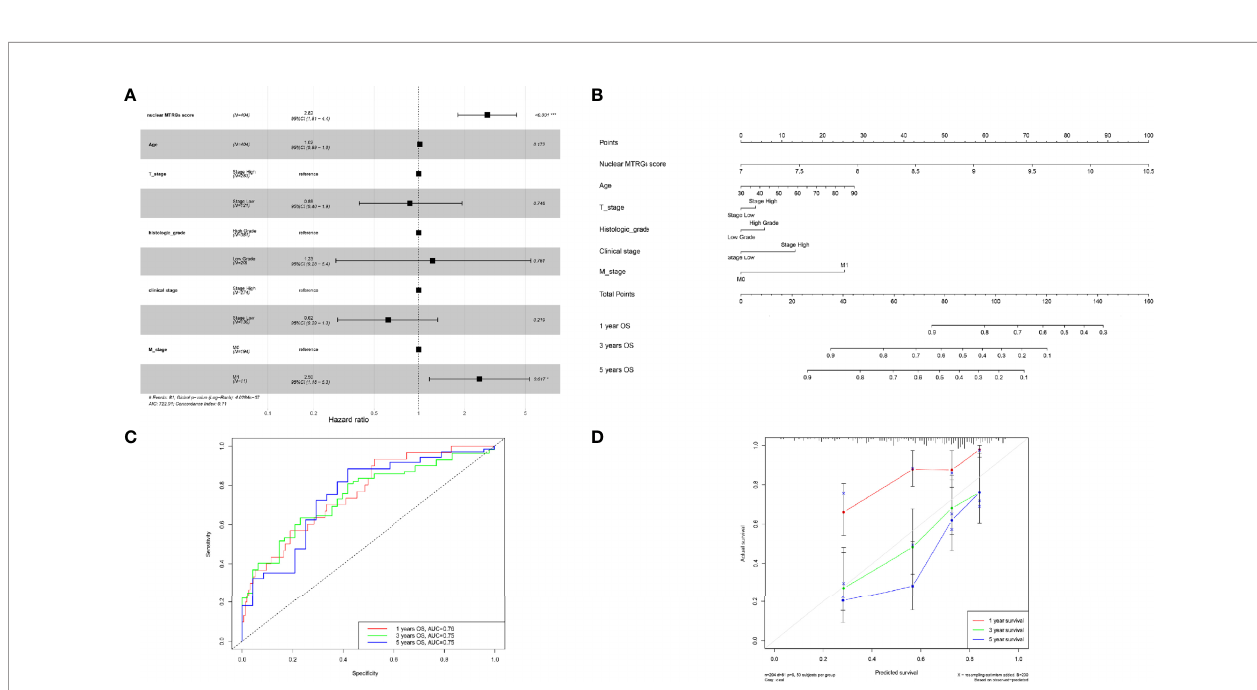
FIGURE 9 | Construction and evaluation of a nomogram. (A) The multivariate Cox regression analysis for the nuclear MTRGs signature and clinical indexes. (B) The constructed nomogram to predict the OS possibilities of BC patients. (C) The ROC curves of the nomogram for OS at 1, 3, and 5 years. (D) Calibration blots indicated the agreement between the predicted OS and actual OS at 1, 3, and 5 years. *p < 0.05, ***p <